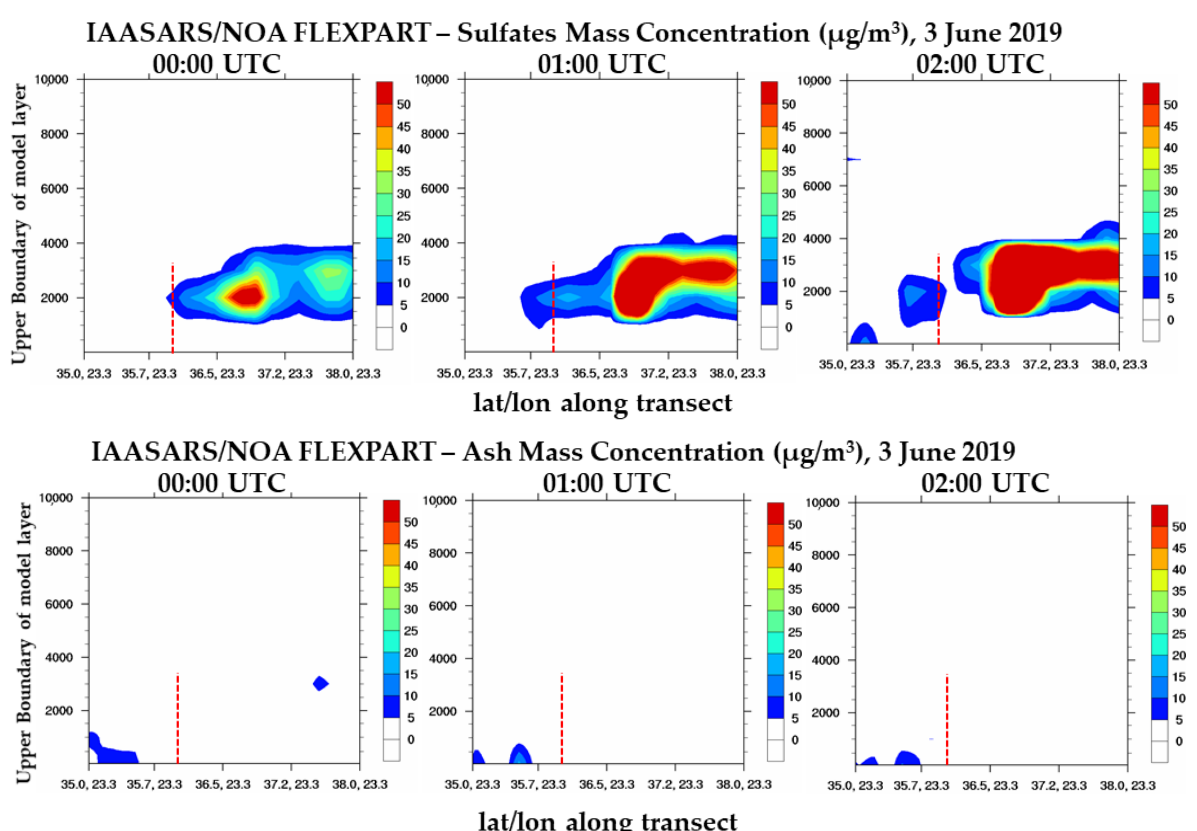
Figure 5. Vertical cross-sections of the simulated mass concentrations ( µ g/m 3 ) over the greater Antikythera region, for sulfates ( a ) and ash ( b ) on 3 June 2019, 00:00–02:00 UTC, as simulated by FLEXPART-WRF. The location of Antikythera station is indicated by the red dashed